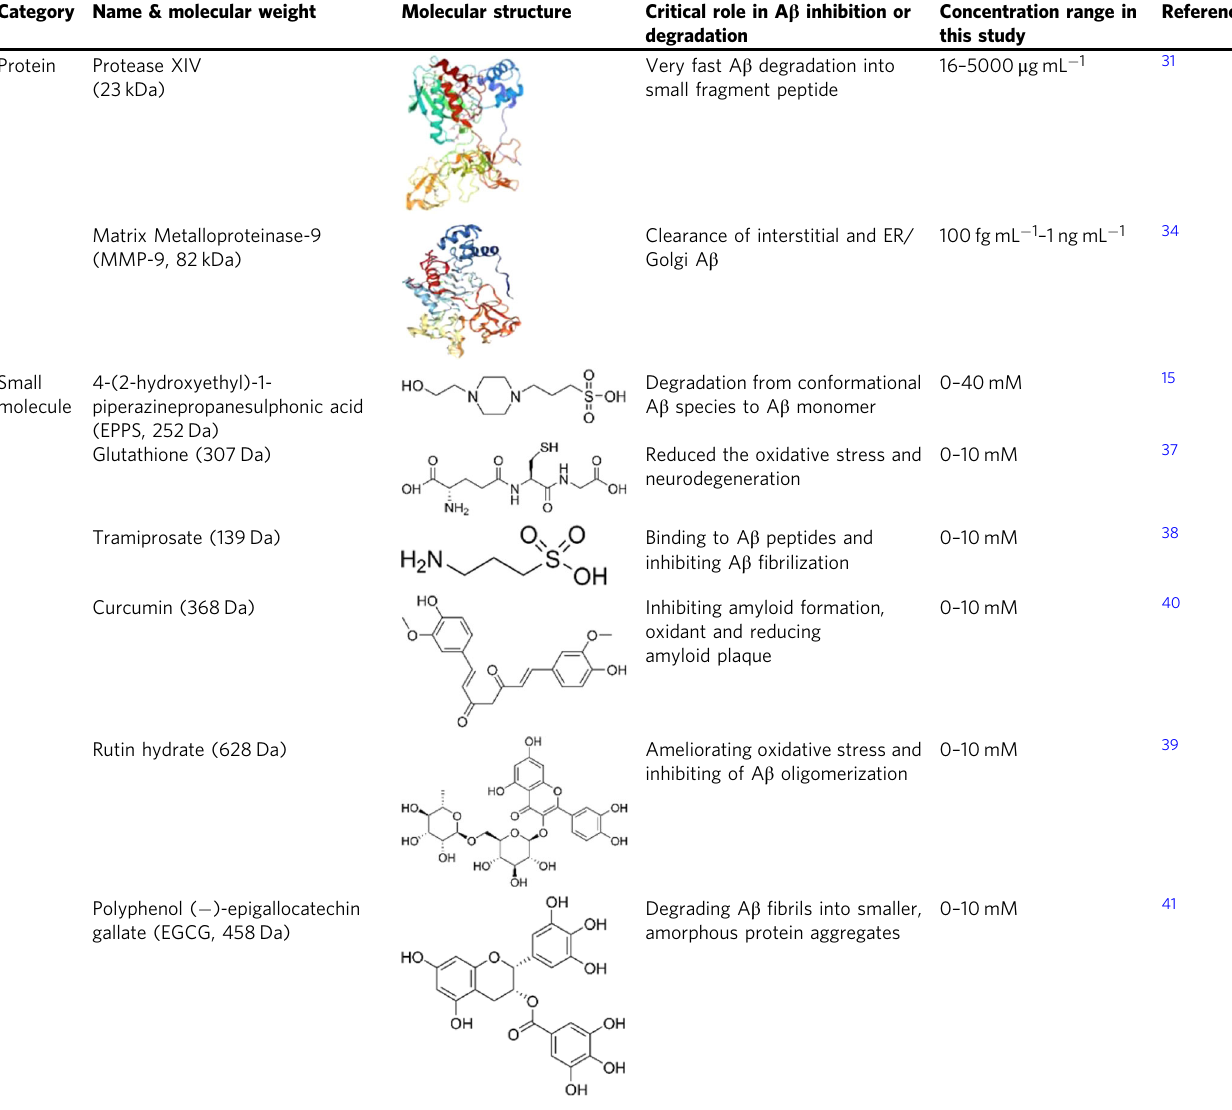
Table 1 List of anti-A β drug candidates used for the validation of the PNAC-based colorimetric drug screening platform. The structure of protease XIV (PDB ID:1OS8) and active site of MMP-9 (PDB ID:1L6J) are shown as cartoon representation. Category Name & molecular